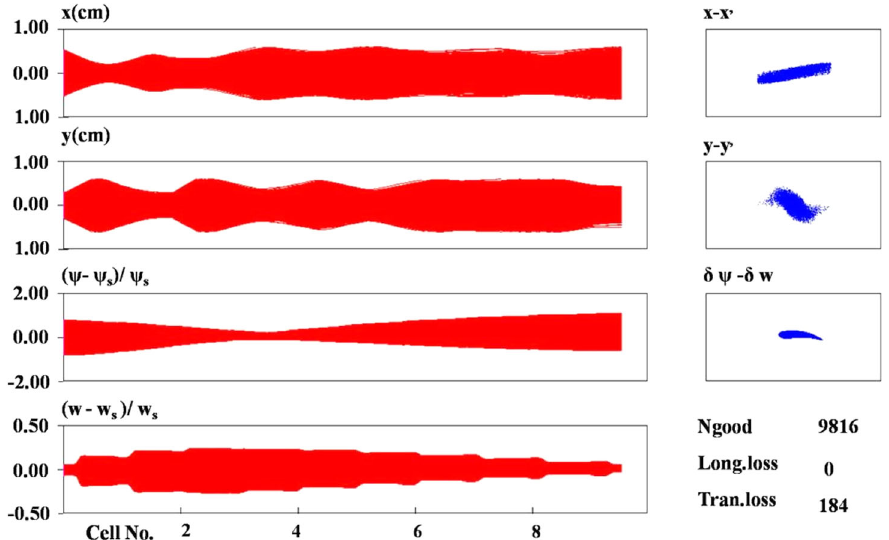
FIG. 12. Transverse and longitudinal beam envelope in SFRFQ.